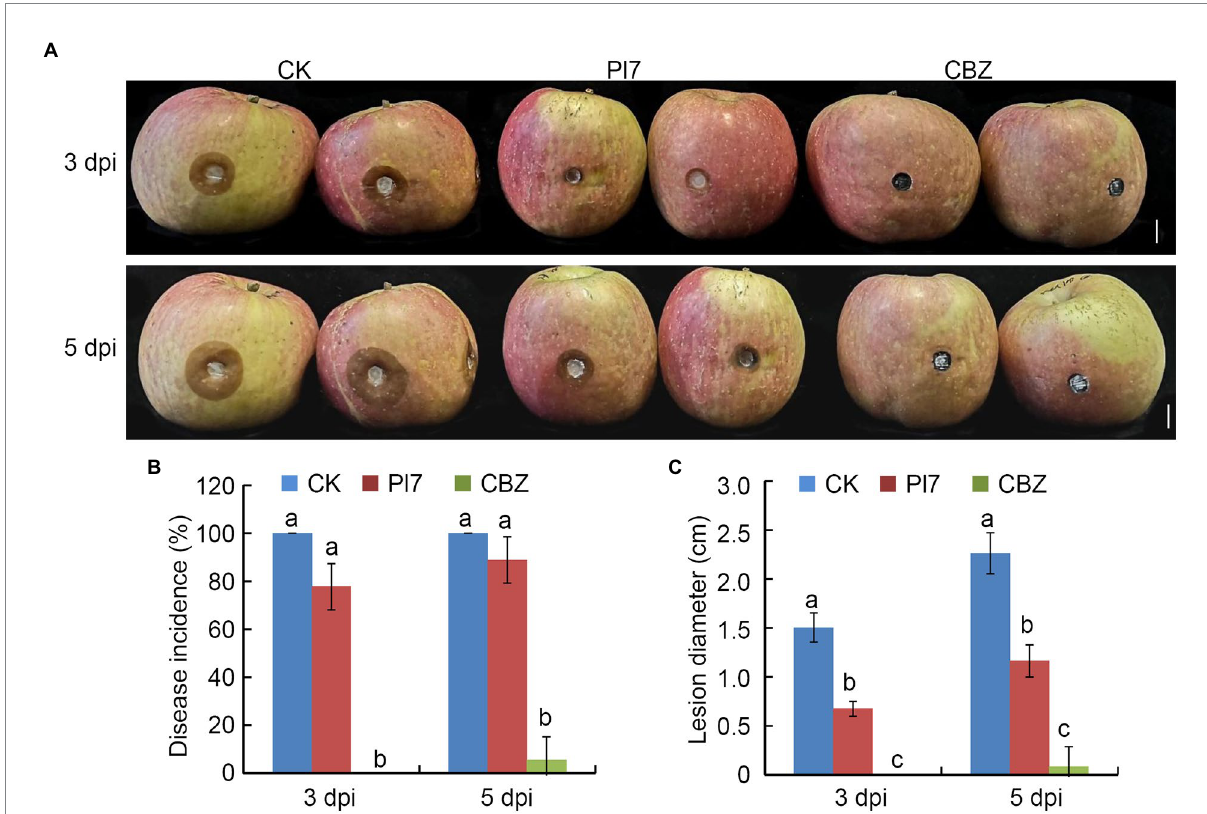
FIGURE 7 Antifungal activity of B. halotolerans strain Pl7 prevents apple ring rot. (A) Controlling apple ring rot by strain Pl7 cell suspension. CBZ treatment was employed as positive control. Bar, 1 cm. (B) Disease incidence. Each treatment consisted of five fruits with 10 inoculation sites. At 3 and 5 dpi, the number of diseased sites were recorded. Disease incidence (%) represents the percentage of the number of diseased sites out of total treated sites. Data are presented as the mean ± SD of three independent replicates. (C) Disease lesion size. Data are presented as the mean ± SD of three biological replicates. Different lowercase letters represent significantly different means at p < 0.05 (Duncan’s multiple test). This experiment was performed independently three times with similar